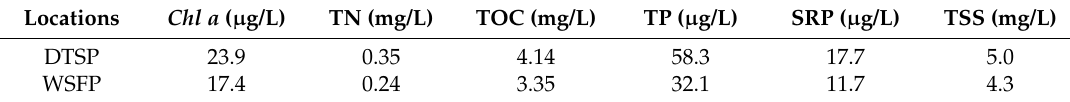
Table 1. Difference of trophic level in field stations supported with field data.